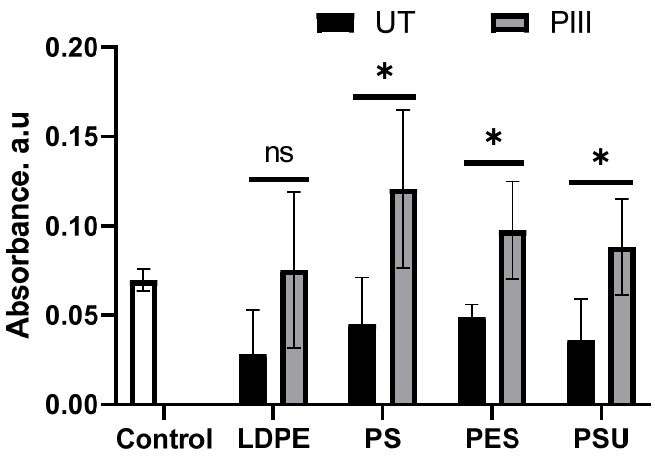
Figure 9. Comparison of MIN6 β -cell adhesion on untreated and PIII-treated polymers coated with laminin from XTT calorimetric assays. Control wells are standard tissue-culture 96-well plate. Error bars were calculated from three replicates. The differences between UT and PIII-treated samples were analysed using unpaired t -tests with statistically significant differences shown as * p < 0.05 ( n = 3).